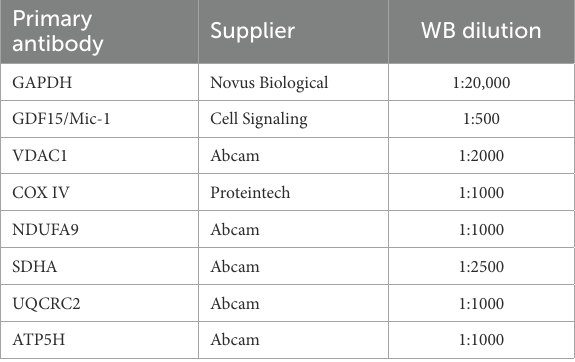
TABLE 2 List of primary antibodies